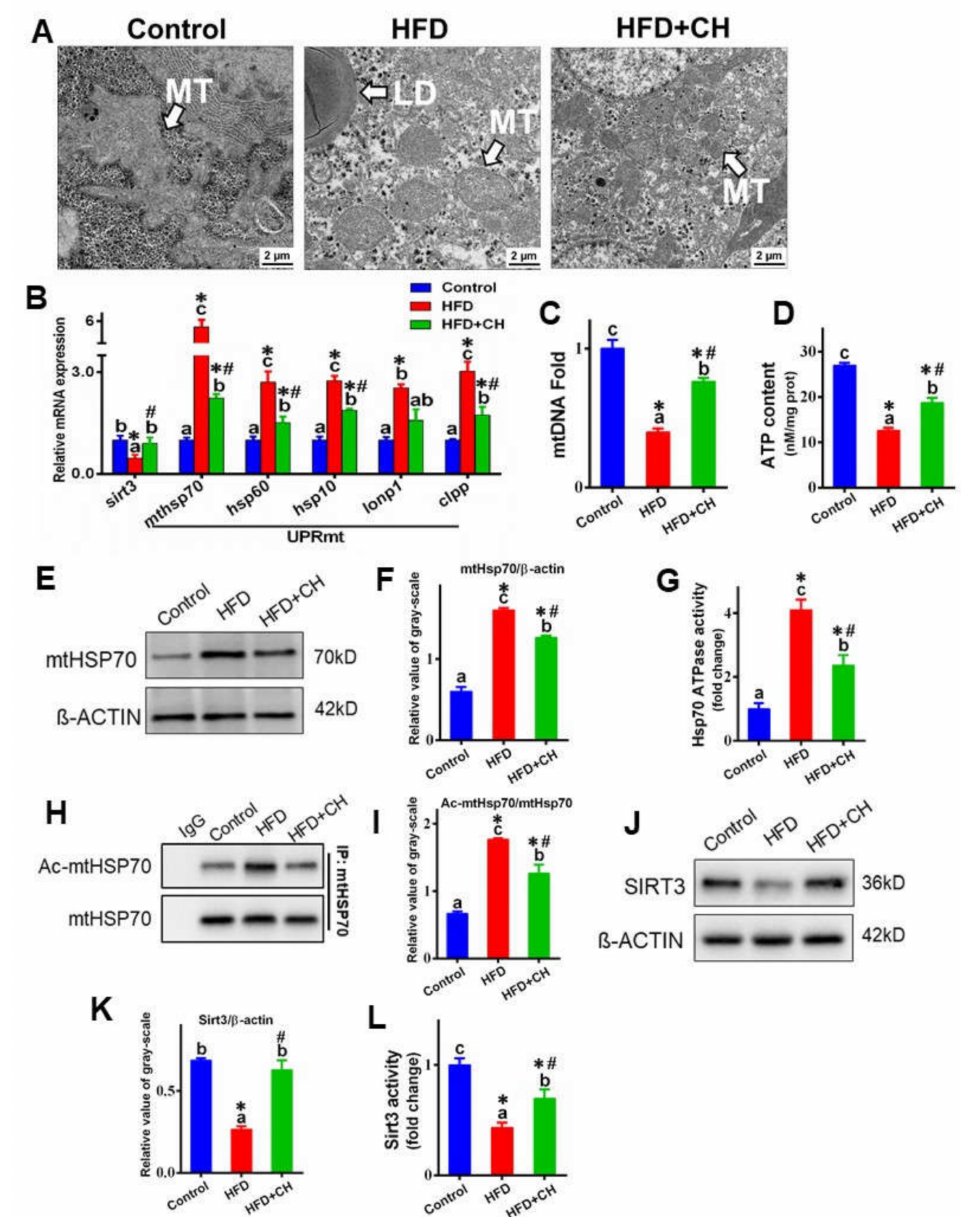
Figure 2. The involvement of SIRT3-mediated mtHSP70 acetylation in dietary choline attenuating HFD-induced mitochondrial unfolded protein response (UPRmt) in the livers of yellow catfish. ( A ) TEM structures of the liver, mitochondrion (MT), lipid droplet (LD); scale bars, 2 µ m. ( B ) The mRNA levels of the genes related to SIRT3 and UPRmt. ( C ) The mtDNA fold. ( D ) ATP content. ( E , F ) Western blot analysis and quantification analysis of mtHSP70. ( G ) HSP70-ATPase activity. ( H , I ) Western blot analysis and quantification analysis of mtHSP70 acetylation. ( J , K ) Western blot analysis and quantification analysis of SIRT3. ( L ) SIRT3 deacetylase activity. Data are mean ± SEM ( n = 3 replicate tanks). Different letters indicate significant differences among groups, asterisks * indicate significant differences between control and HFD/or HFD + CH, and pound # indicates significant differences between HFD and HFD + CH ( p ≤